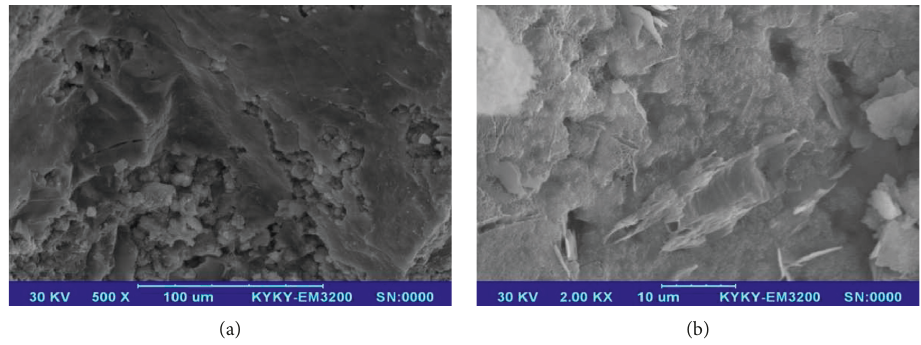
Figure 9: Microstructures of 20% FA: (a) 500 × and (b) 2,000 × .